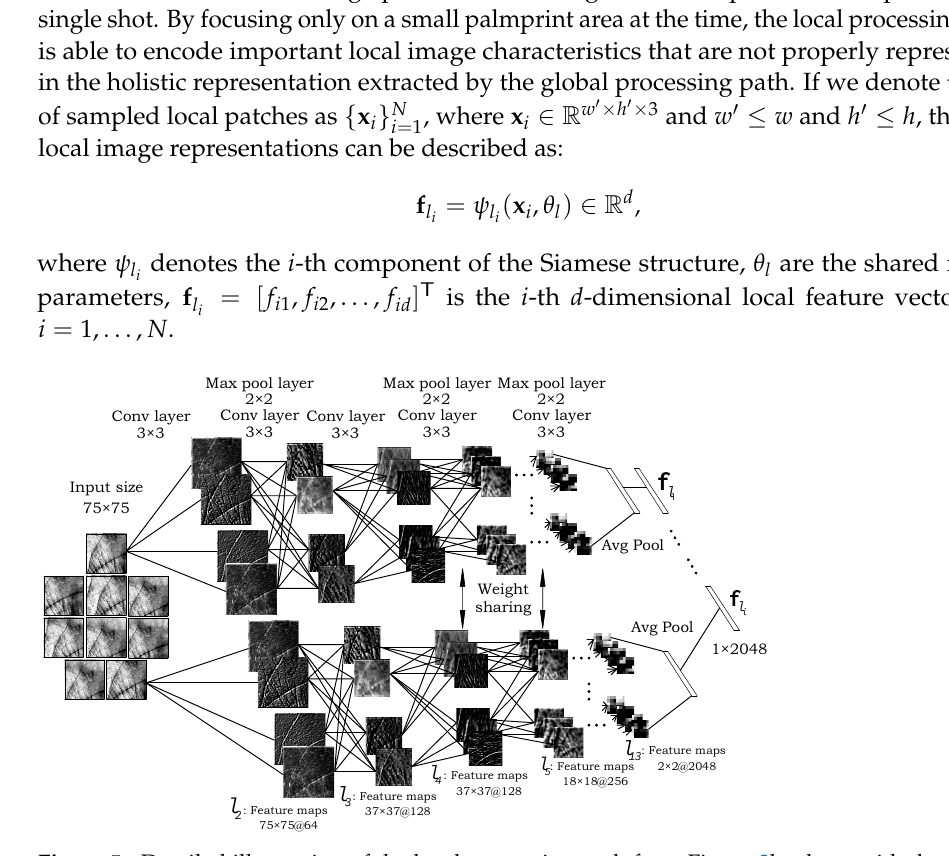
Figure 5. Detailed illustration of the local processing path from Figure 3b, along with the feature maps learned at different levels of the model. Image patches, sampled from the input image in a grid-like manner, are processed by a parallel backbone Siamese CNN with shared model parameters resulting in N local image features f l , where i = 1, . . . , N i